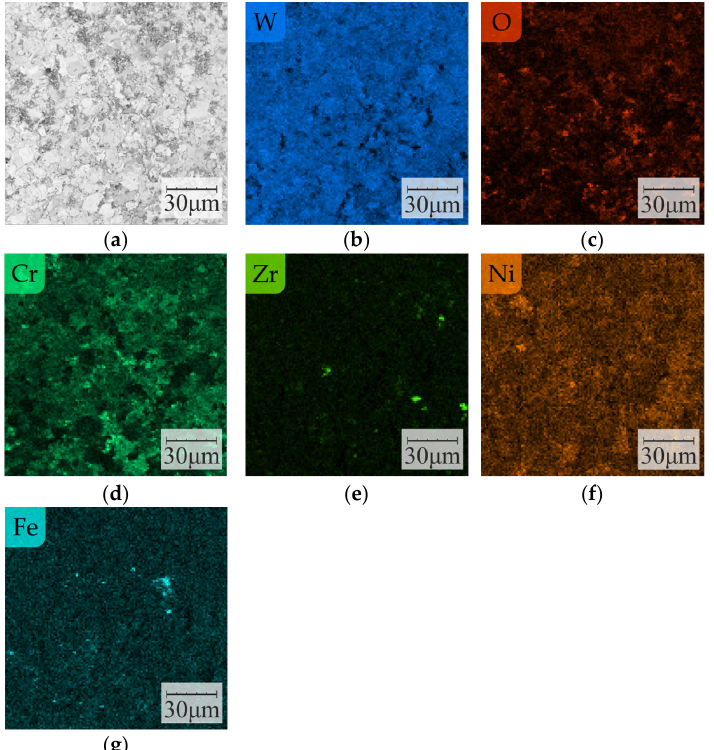
Figure 12. The surface morphology of the D-type sample (10 wt. % addition of YSZ powder) after the tribological test ( a ) and elemental mapping of W ( b ), O ( c ), Cr ( d ), Zr ( e ), Ni ( f ), and Fe ( g ). However, it should be noted that in the period from 90 to 178 min. for the recipro-